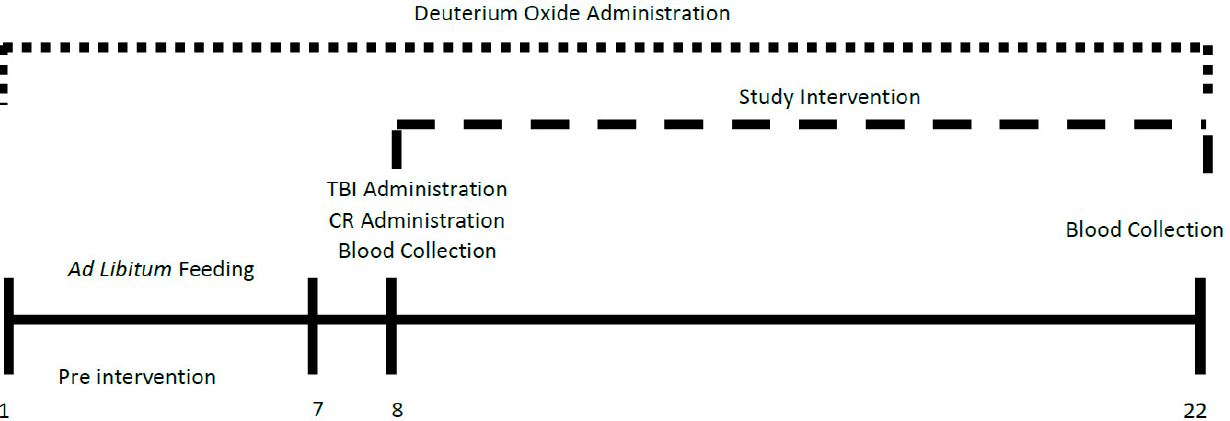
Figure 1. An experimental schematic of the study. Animals were housed individually, and on day 1 we provided 6% D 2 O drinking water that was maintained for the entirety of the study (21 days). Days 1–7 were considered pre-study where the animals were given AL access to food; food intake and water intake were measured daily. On day 8 the rats were randomized into the study groups: Ad libitum (AL) fed control (AL-Con, sham), AL plus TBI (AL+TBI), CR control (CR-Con, sham), and CR plus TBI (CR+TBI). Following a blood draw, the animals received a TBI or a sham intervention. Following the TBI or sham intervention, half rations were provided to the animals selected for CR treatment. From days 9–21, the animals were allowed to recover in their cages. On day 22 the animals were euthanized, and blood was collected.